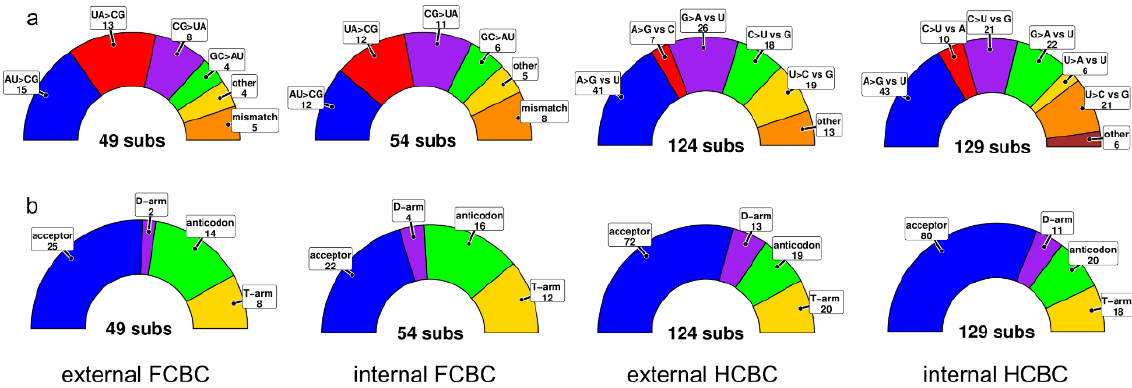
Figure 6. Full compensatory base changes (FCBCs) and hemi-compensatory base changes (HCBCs) in tRNAs. Type of nucleotide substitutions in full compensatory base changes and hemi-compensatory base changes ( a ) and number of nt switches per tRNA arm ( b ) deduced to be on internal and external branches of the phylogenetic tree.